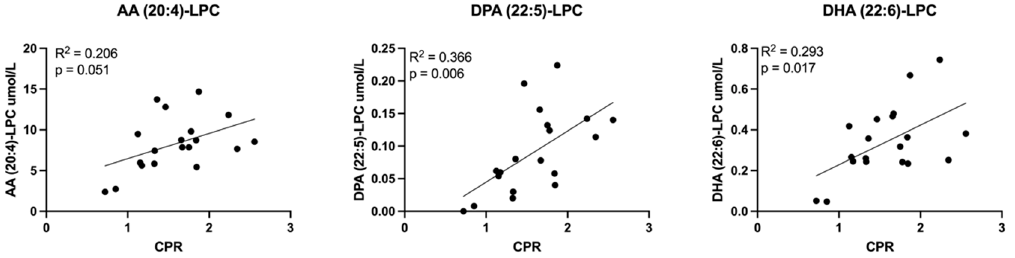
Figure 10. Correlations between umbilical vein plasma lipid concentrations and umbilical artery pulsatility index (UA PI): non-esterified fatty acids. Scatterplots demonstrate correlation relationships between UA PI and umbilical vein plasma concentrations of non-esterified long chain polyunsaturated fatty acids, arachidonic acid (20:4) and docosahexaenoic acid (22:6). Pearson correlation coefficient was computed to assess relationships.